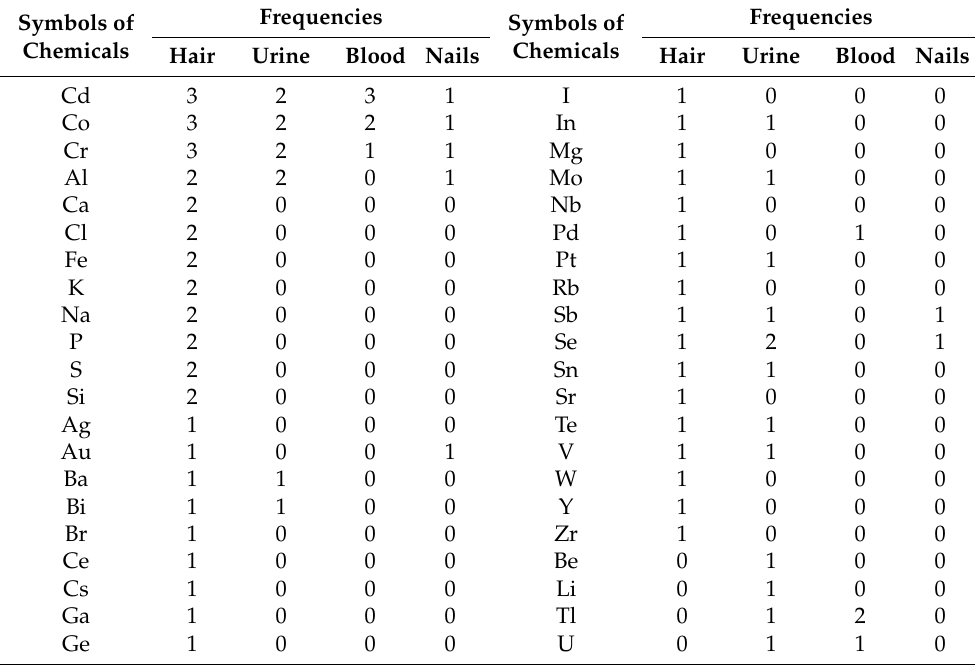
Table A4. Type of chemical pollutants and frequency of reporting studies per type of human samples. Frequencies of reporting articles are given for pollutants reported in up to three studies, each.